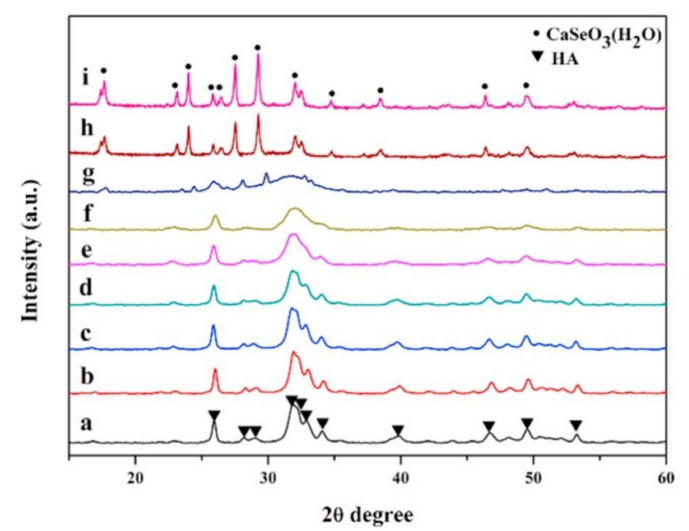
Figure 4. XRD patterns of the pure HA and Se-HA samples with different Se/P ratios: ( a ) HA; ( b ) Se/P = 0.05; ( c ) Se/P = 0.08; ( d ) Se/P = 0.1; ( e ) Se/P = 0.3; ( f ) Se/P = 0.5; ( g ) Se/P = 1; ( h ) Se/P = 3; and ( i ) Se/P = 5. Reprinted from [33] with permission from